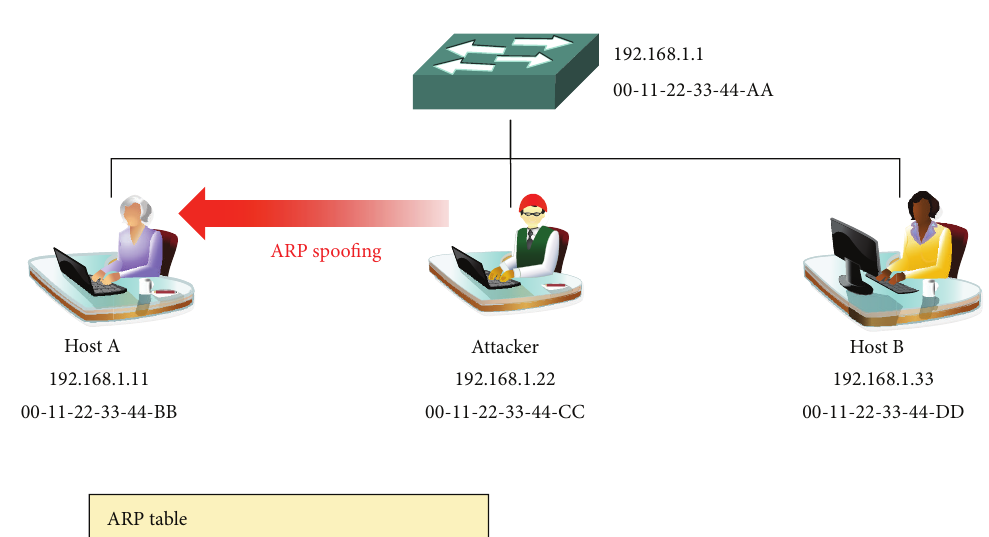
Figure 4: Protocol for the protection stages.